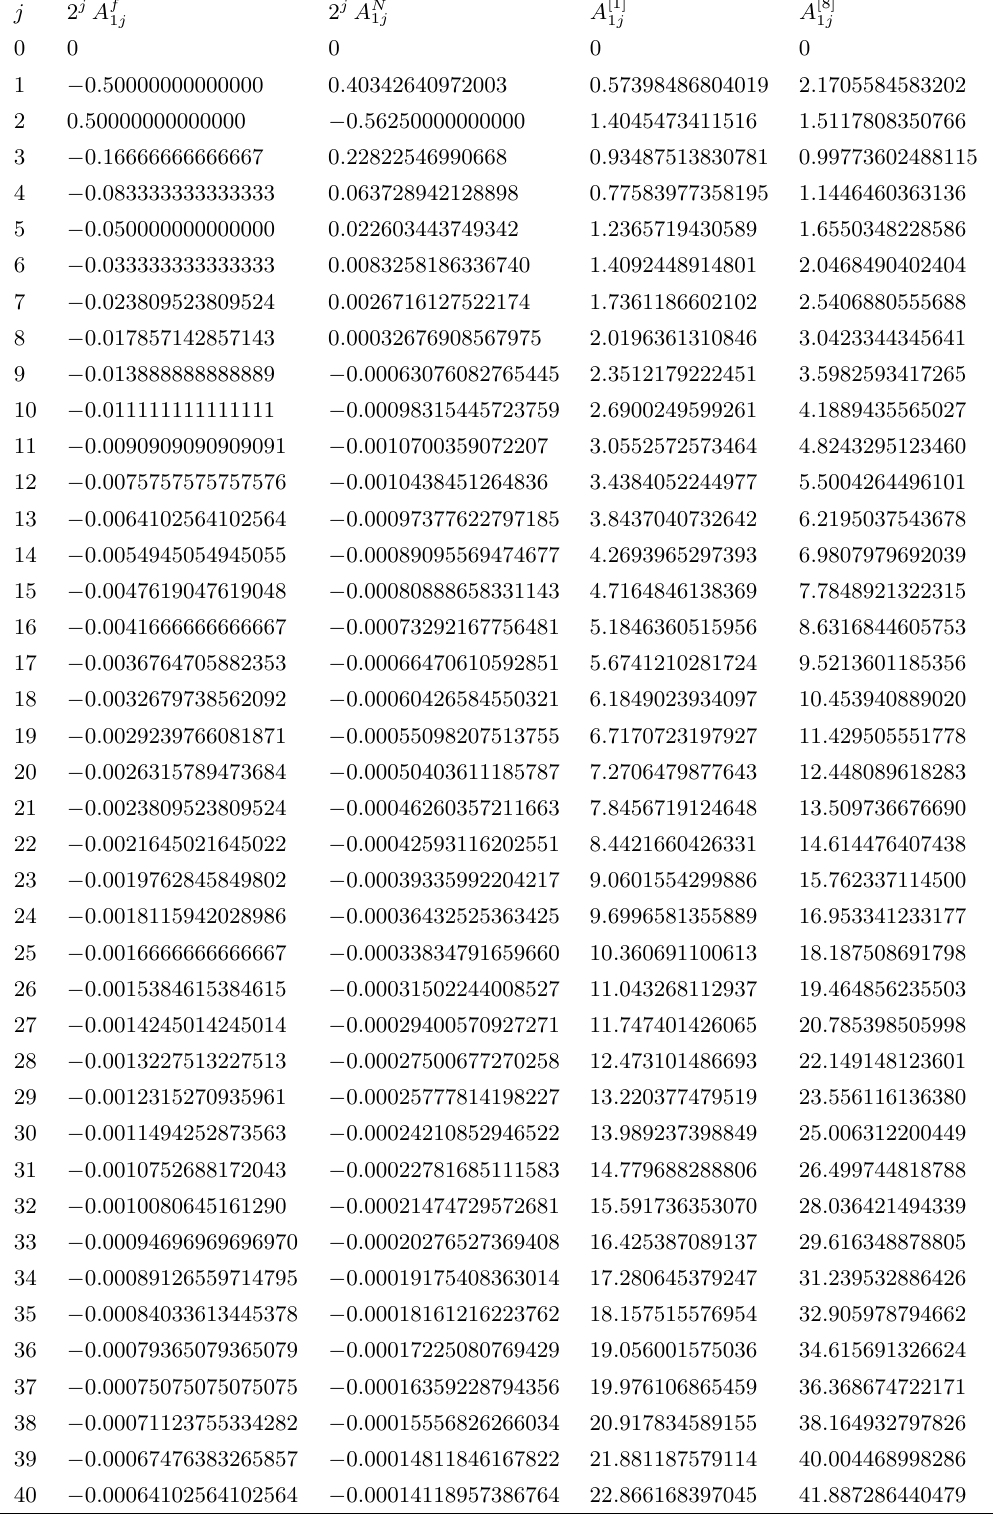
Table 4 . Coe(cid:14)cients of the term including ln 1 ( z ) in the asymptotic expansion at z = 0.